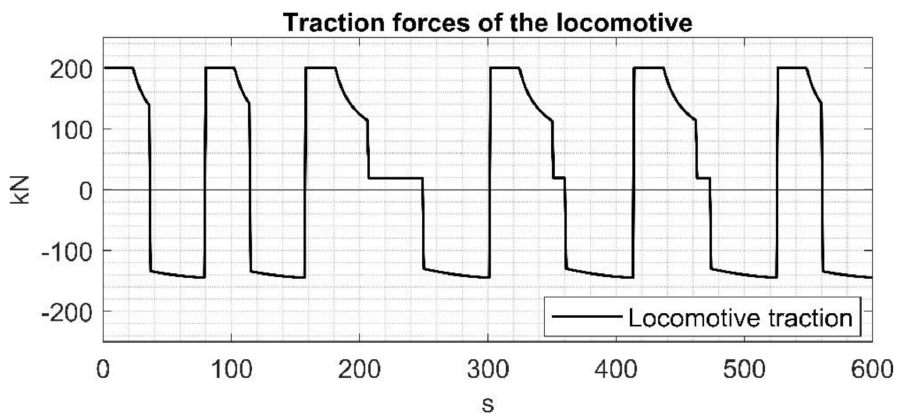
Figure 3. Locomotive forces in the first 600 s.